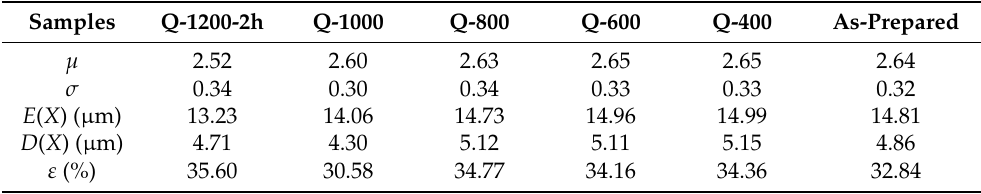
Table 1. Average grain sizes for the quenched and as-prepared samples.